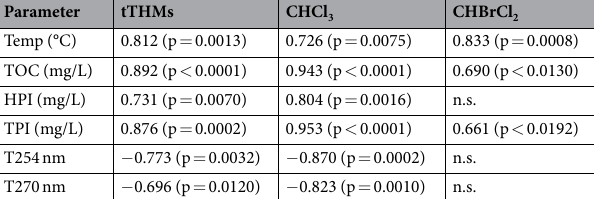
Table 1. Statistically significant linear Pearson correlations between monthly averages of the total or individual THMs and other water quality parameters in potable water from five Scottish water treatment plants (n.s. = p > 0.05, CHBr 2 Cl and CHBr 3 had no significant